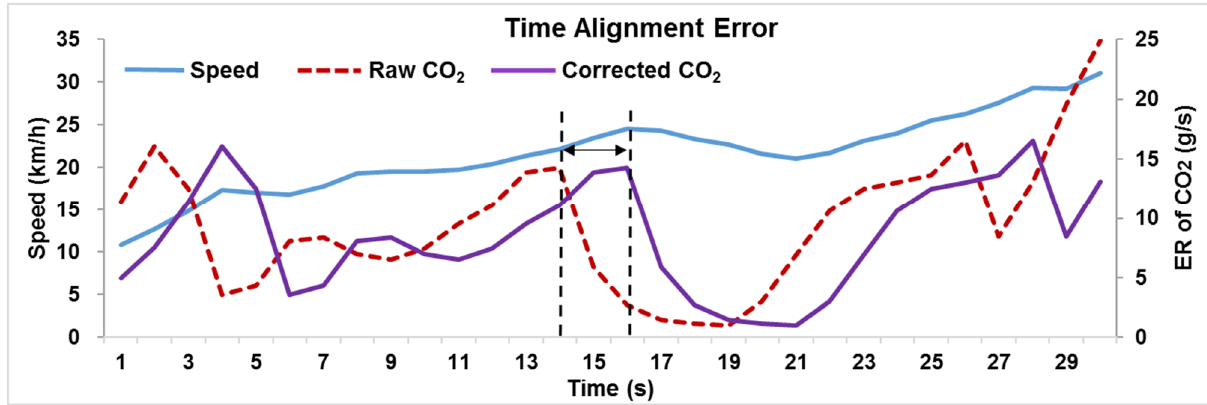
Figure 3. Time alignment error of CO 2 emission data steam.